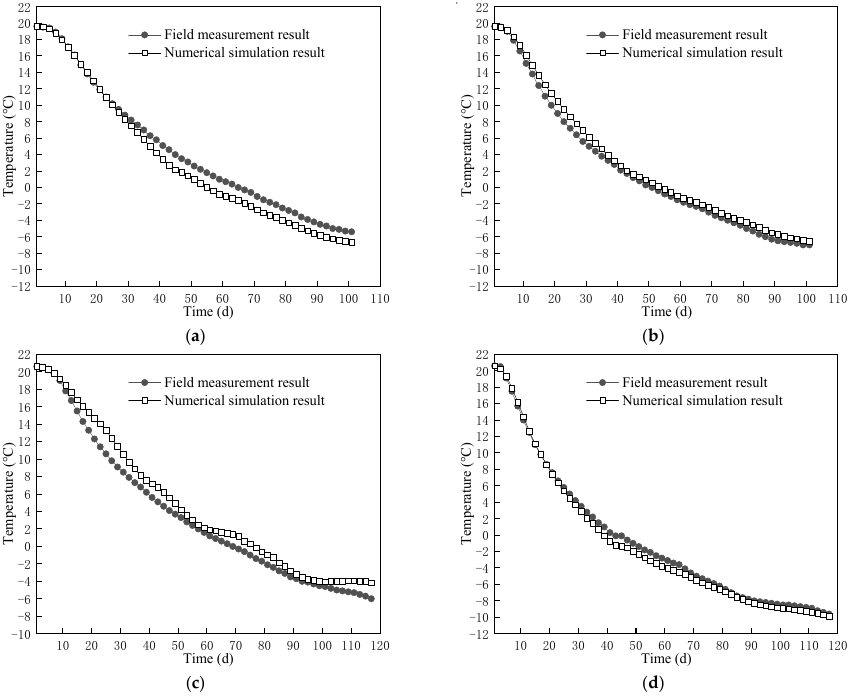
Figure 6. Comparisons of measured and simulated temperature measuring points. ( a ) C1 temperature measurement point of − 87 m fine sandy soil; ( b ) C2 temperature measurement point of − 87 m fine sandy soil; ( c ) C1 temperature measurement point of − 135 m fine sandy soil; ( d ) C2 temperature measurement point of − 135 m fine sandy soil.